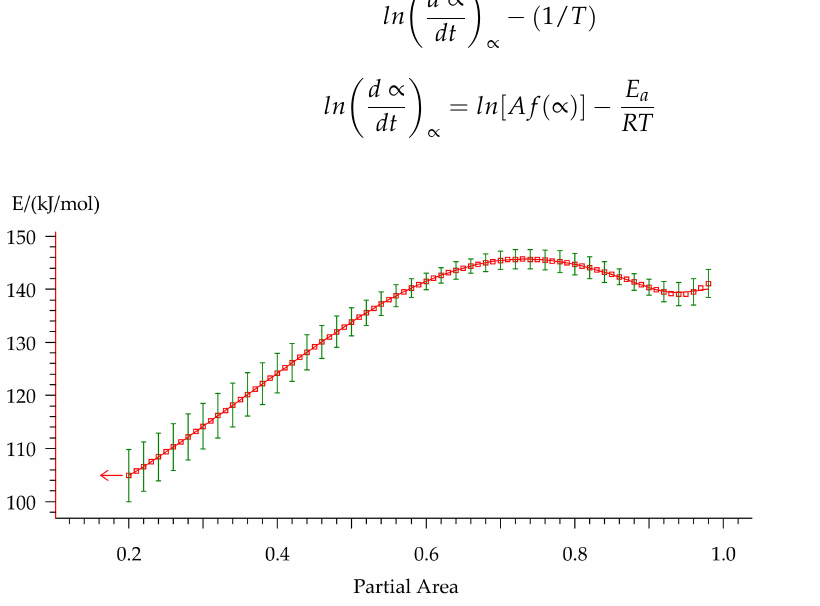
Figure 11. The E a -dependency for non-isothermal curing of formulation 2 on the degree of